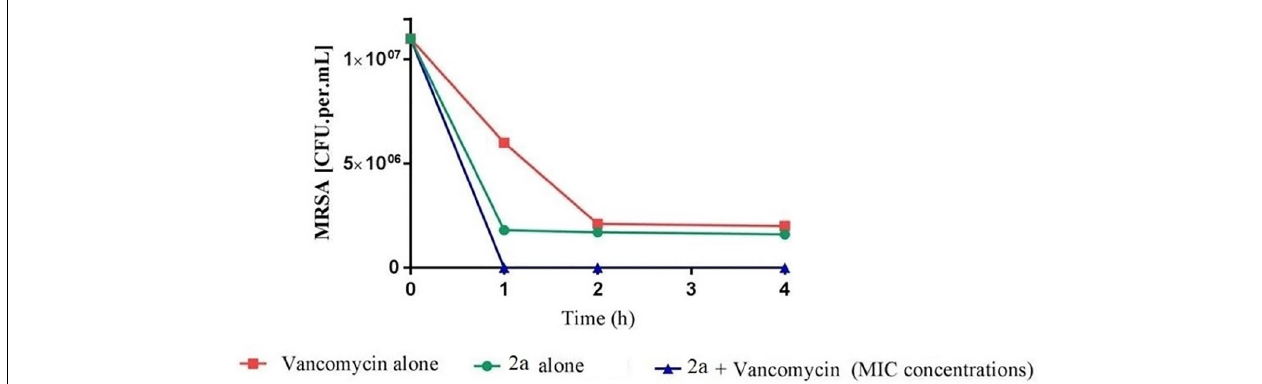
FIGURE 10 | Time-kill curve study of combinations of vancomycin and 2a versus MRSA at drug exposure in MIC concentrations. The curve displays the mean CFU for duplicate samples and represents data from two independent experiments. Twelve doubling dilutions are plotted, the highest concentration ( black line ) corresponds to 16 × MIC. Growth in absence of antimicrobial is drawn in red . The compound was added at time point 0 and monitored until 24 h. The limit of detection in the assay was 100 CFU mL − 1 .